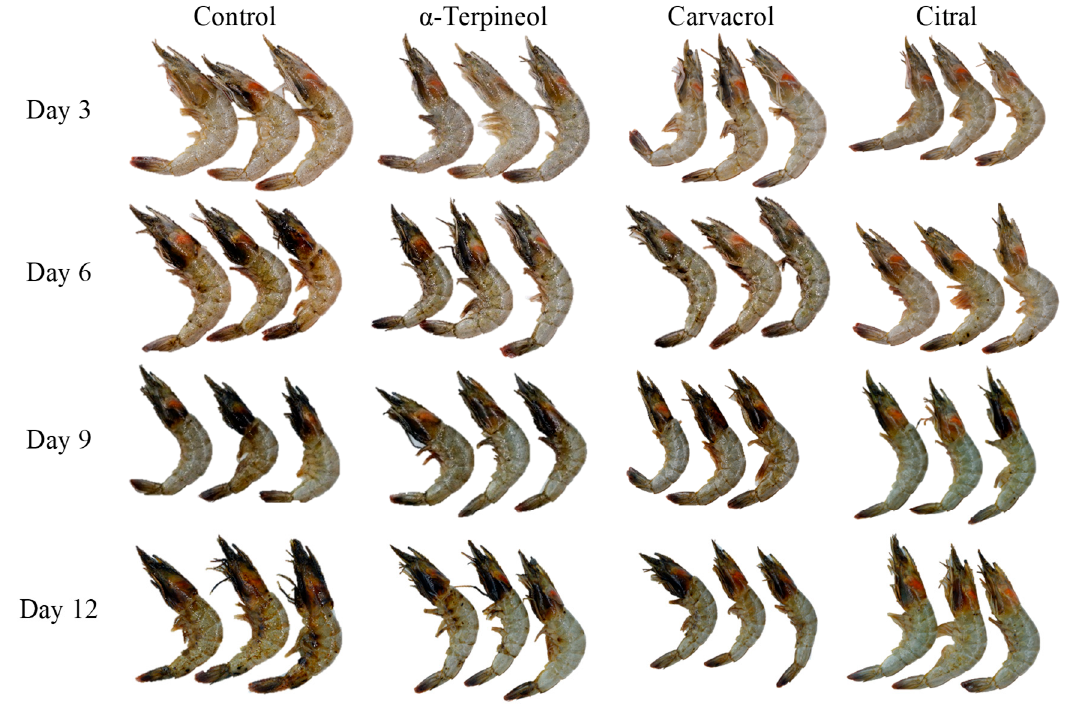
Figure 3. Shrimp packaged in PBAT/PLA film containing 6% α -terpineol, carvacrol, and citral during 12 days of storage at 4 °C.